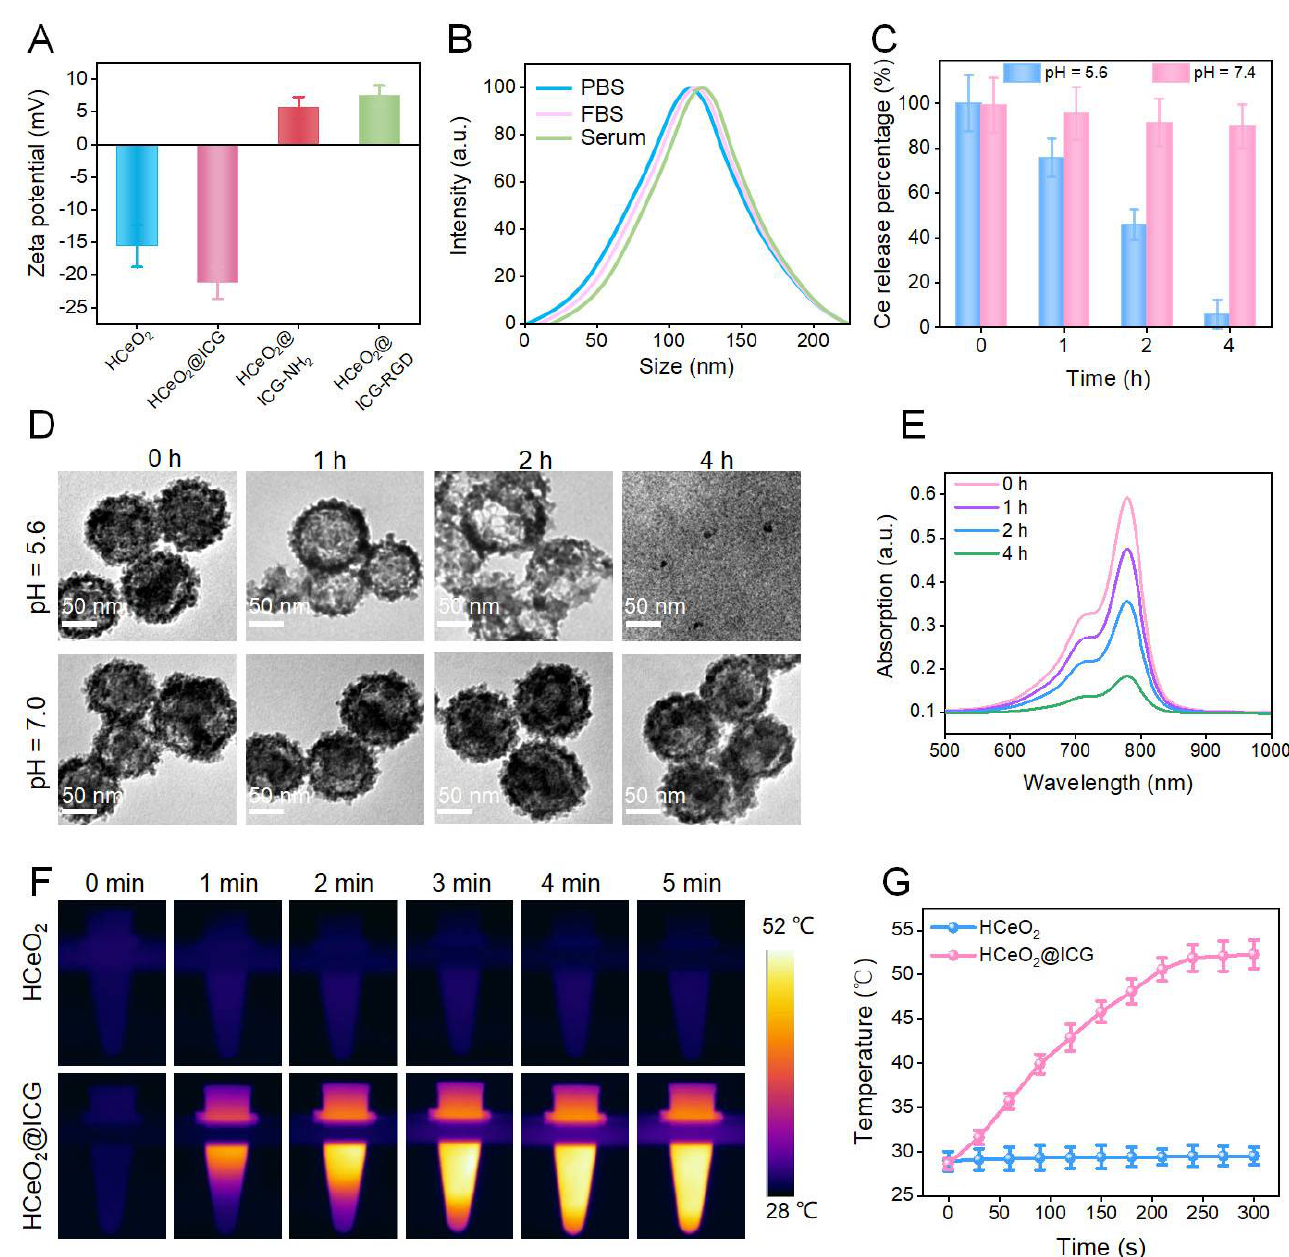
Figure 3. Zeta potential values of HCeO 2 , HCeO 2 @ICG, HCeO 2 @ICG−NH 2 , and HCeO 2 @ICG−RGD ( A ). Size distribution of HCeO 2 @ICG-RGD dispersed in PBS, FBS, and serum for 7 days ( B ). Ce ions release ( C ), TEM images ( D ) of HCeO 2 @ICG−RGD incubated in pH = 5.6 and 7.4 buffers for different times. ( E )The released ICG fluorescence intensity of HCeO 2 @ICG−RGD incubated in pH = 5.6 for various durations. Infrared thermal images and ( F ) and temperature curve ( G ) of the solution containing HCeO 2 or HCeO 2 @ICG under the 808 nm laser (0.75 W cm⁻ 2 ) irradiation for different minutes.